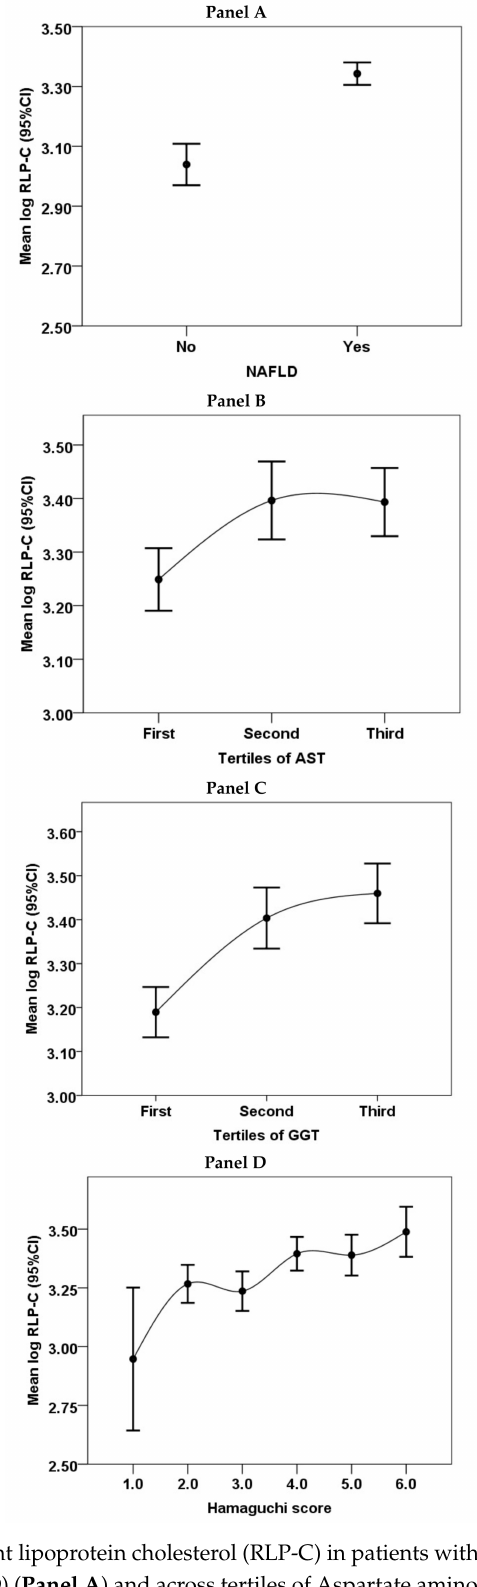
Figure 1. Values of remnant lipoprotein cholesterol (RLP-C) in patients with and without non-alcoholic fatty liver disease (NAFLD) ( Panel A ) and across tertiles of Aspartate aminotransferase (AST) ( Panel B ) and Gamma-glutamyl transpeptidase (GGT) ( Panel C ) and according to the Hamaguchi score ( Panel D ) in patients with